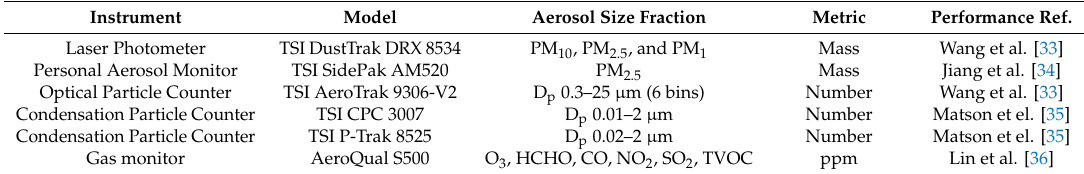
Table 3. List of the portable air quality instruments and the measured